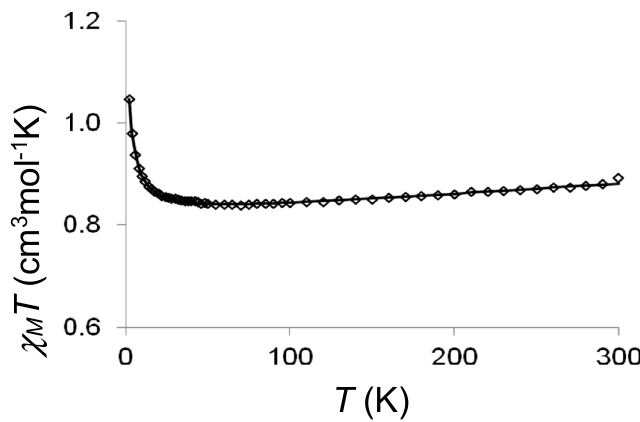
Figure 10. Temperature dependence of the χ M T product for complex 2 at an applied magnetic field of 0.1 T. The solid line corresponds to the best data fit (see text).